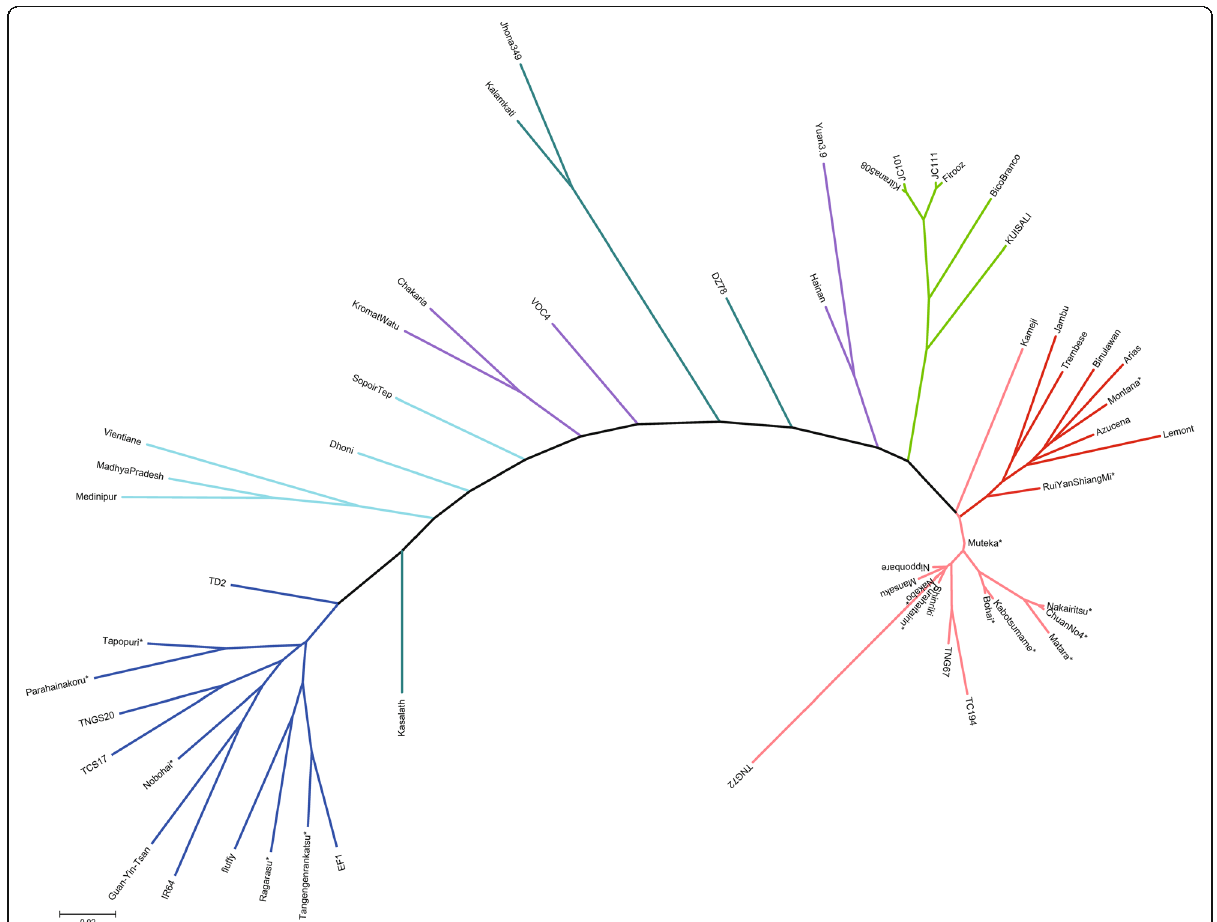
Fig. 3 Phylogeny of the 55 rice accessions. Red: japonica (dark red: tropical japonica ); green: aromatic ; cadetblue: aus ; cyan: wild rice ( Oryza nivara ); blue: indica ; purple: wild rice ( Oryza rufipogon ). Neighbor-joining phylogenetic tree based on all SNPs of the 55 accessions in Additional file 1: Table S4. Bootstrap values determined with 1000 samples are shown. The scale bar indicates the simple matching distance. Aboriginal Formosan accession names are followed by an